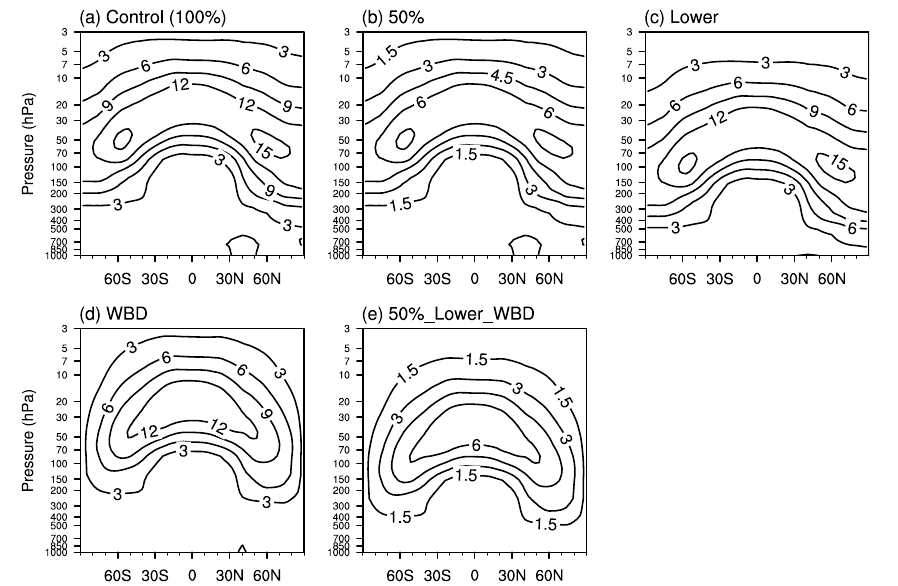
Fig. 1. Vertical cross-sections of annual- and zonal-mean O 3 concentration for different scenarios (units: mPa). (a) control (100%), (b) 50%, (c) lower, (d) WBD, and (e) 50% Lower WBD. See text for detailed descriptions. Contour intervals are 3, 1.5, 3, 3 and 1.5mPa, respectively.